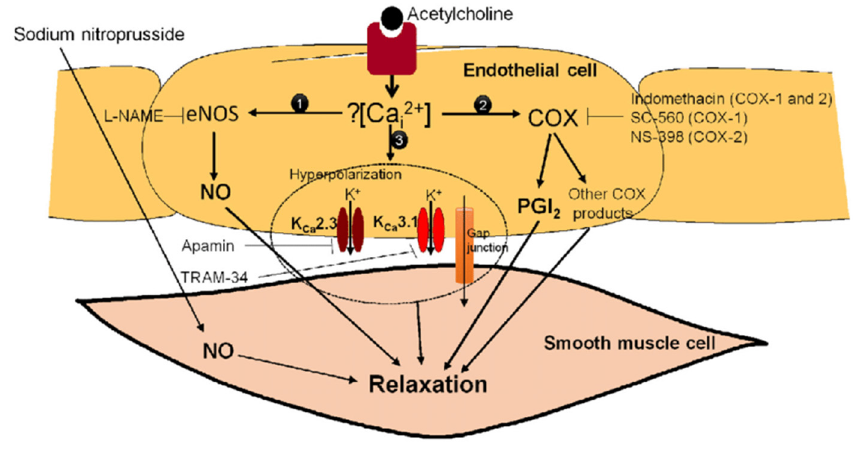
Figure 3. Endothelium-dependent vasodilation.